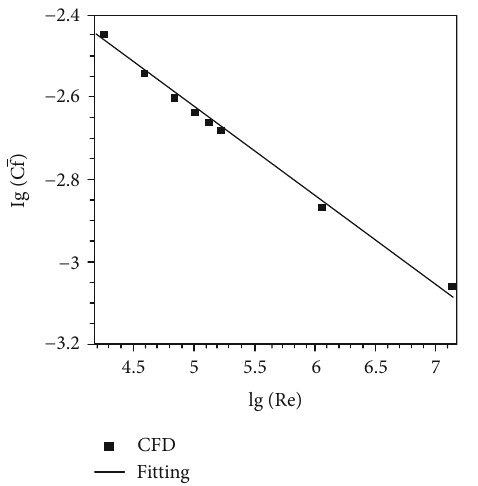
Figure 15: Comparison of the predicted and fi tted average friction coe ffi